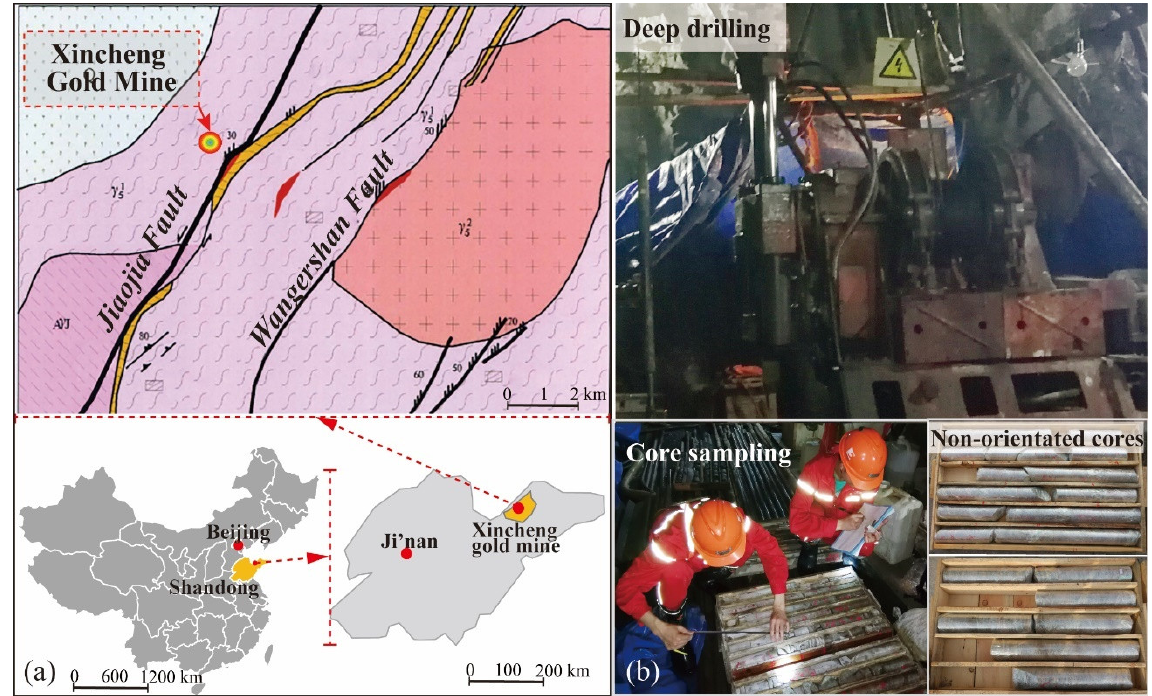
Figure 5. Core sampling at in situ stress measurement area: ( a ) geographic location; ( b ) nonoriented core sampling.